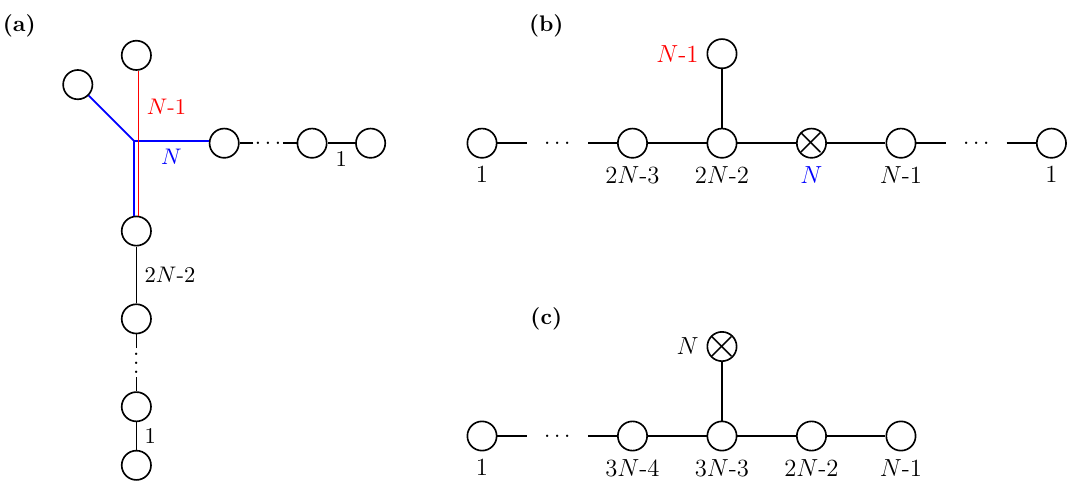
Figure 27 . (a) Strongly coupled brane web for P N with subwebs and magnetic quivers for (b) P N and (c) G N